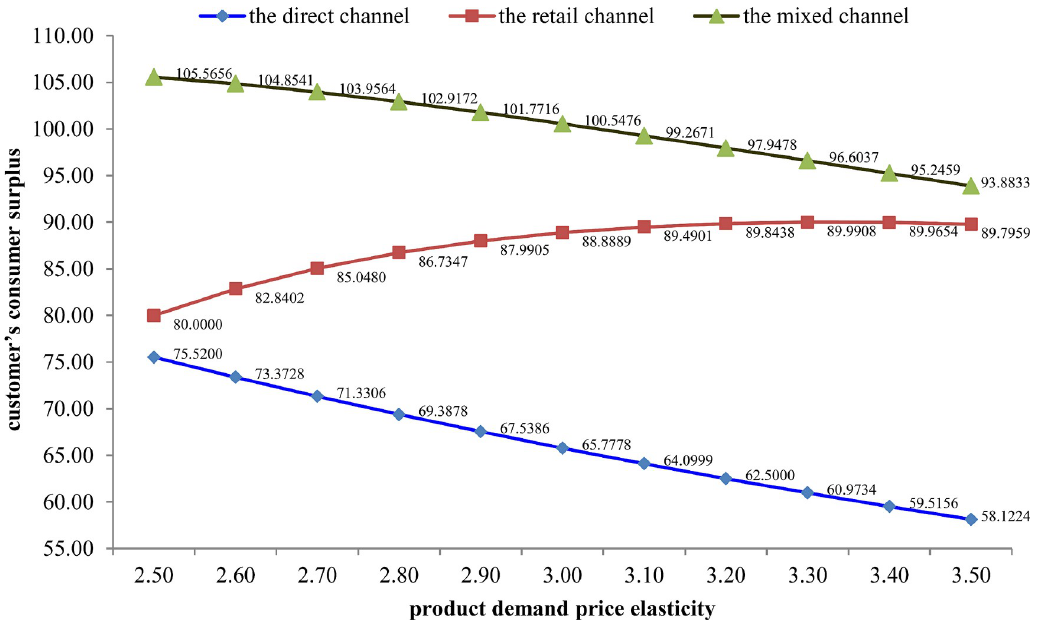
Fig 3. The customer’s consumer surplus in three types of distribution